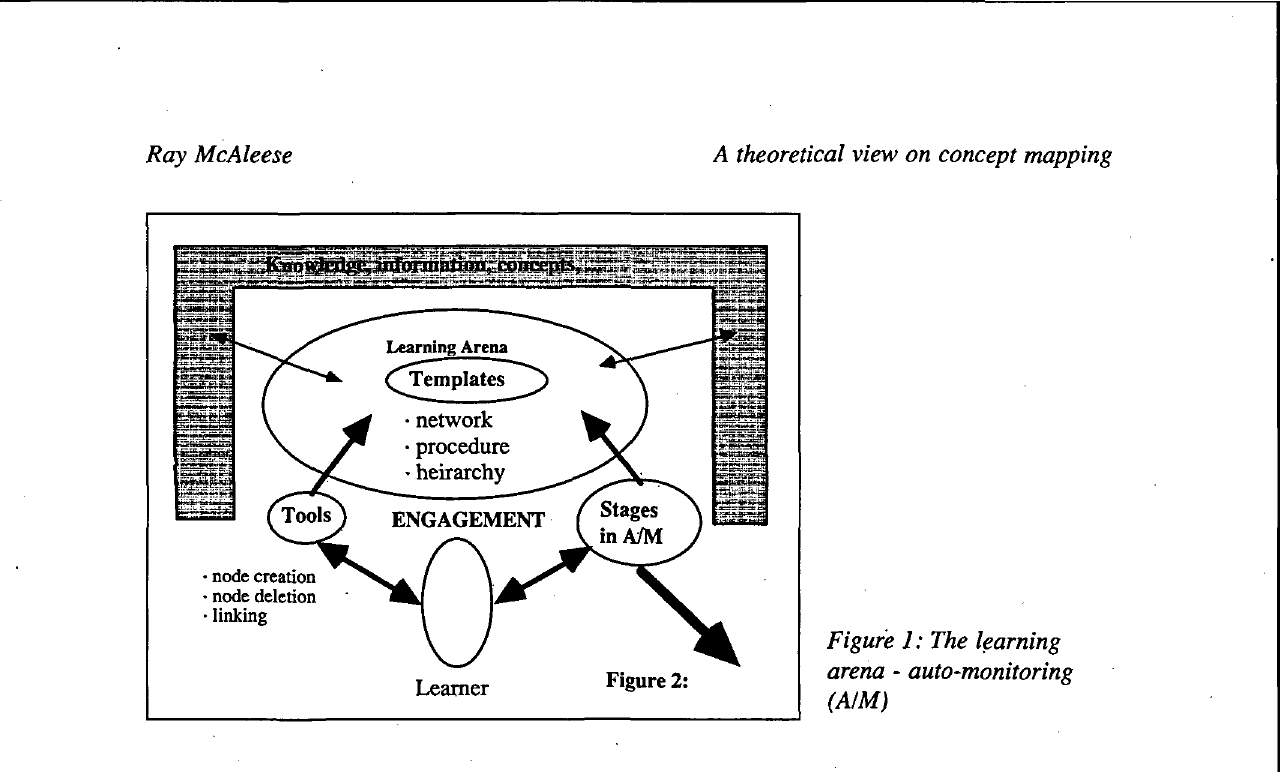
Figure 1: The learning